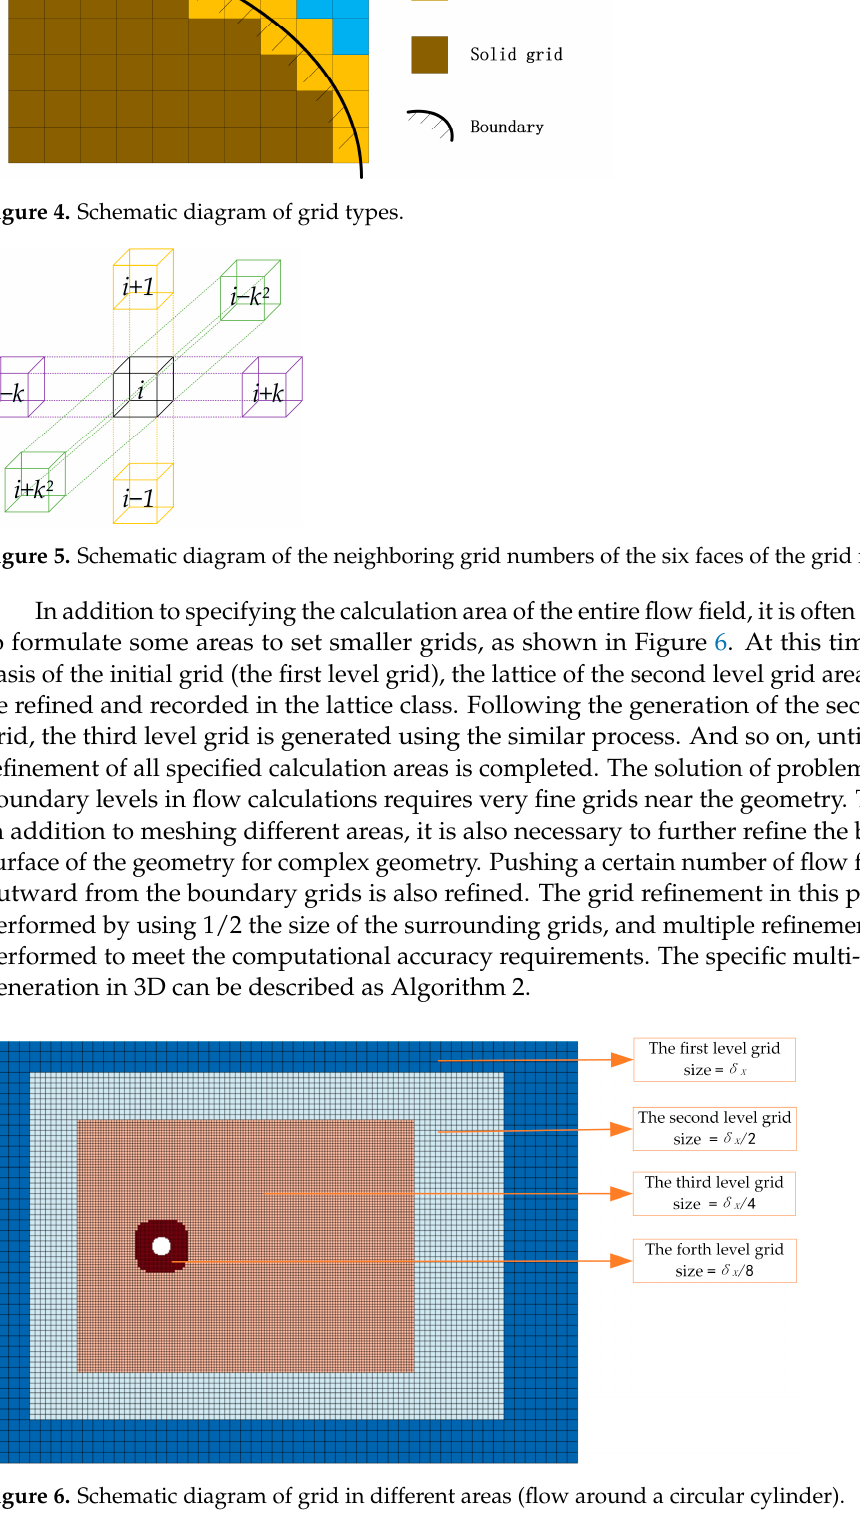
Figure 6. Schematic diagram of grid in different areas (flow around a circular cylinder). Algorithm 2 Multi-level grid generation algorithm.